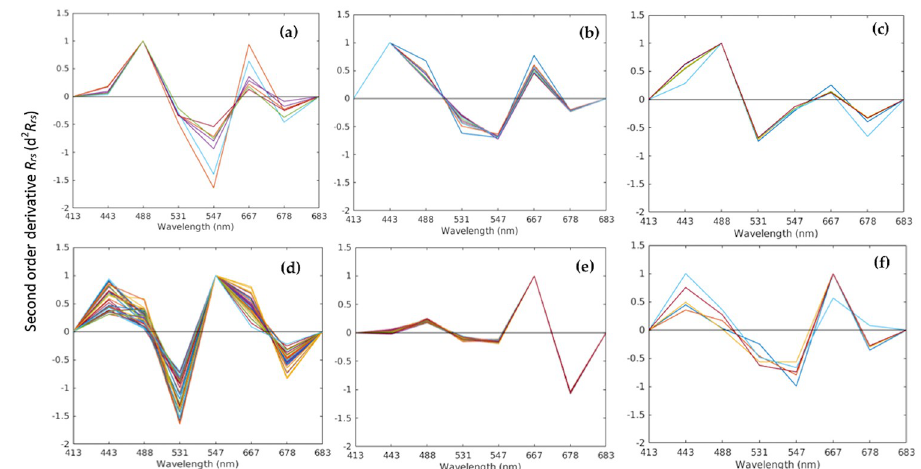
Fig 4. Examples of second-order derivative R rs from daily MODIS-Aqua data for the different HABs in the Red Sea waters. (a) H . akashiwo (b) Ostreopsis sp . (c) K . foliaceum (d) N . scintillans/miliaris (e) C. polykrikoides (f) T . erythraeum .